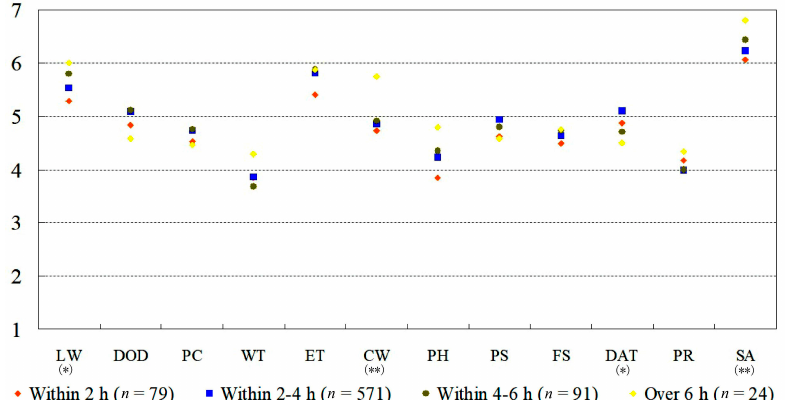
Figure 7. Choice preferences based on duration of stay. LW: Landscape the visitor wants to see; DOD: Degree of difficulty; PC: Pavement condition; WT: Watch the forest train; ET: Experience the forest bath; CW: Contact with landscape elements; PH: Photography; PS: Physical strength; FS: Facility status; DAT: Distance and time; PR: Privacy; SA: Satisfaction. ** Significant at the 0.01 level. * Significant at the 0.05 level.